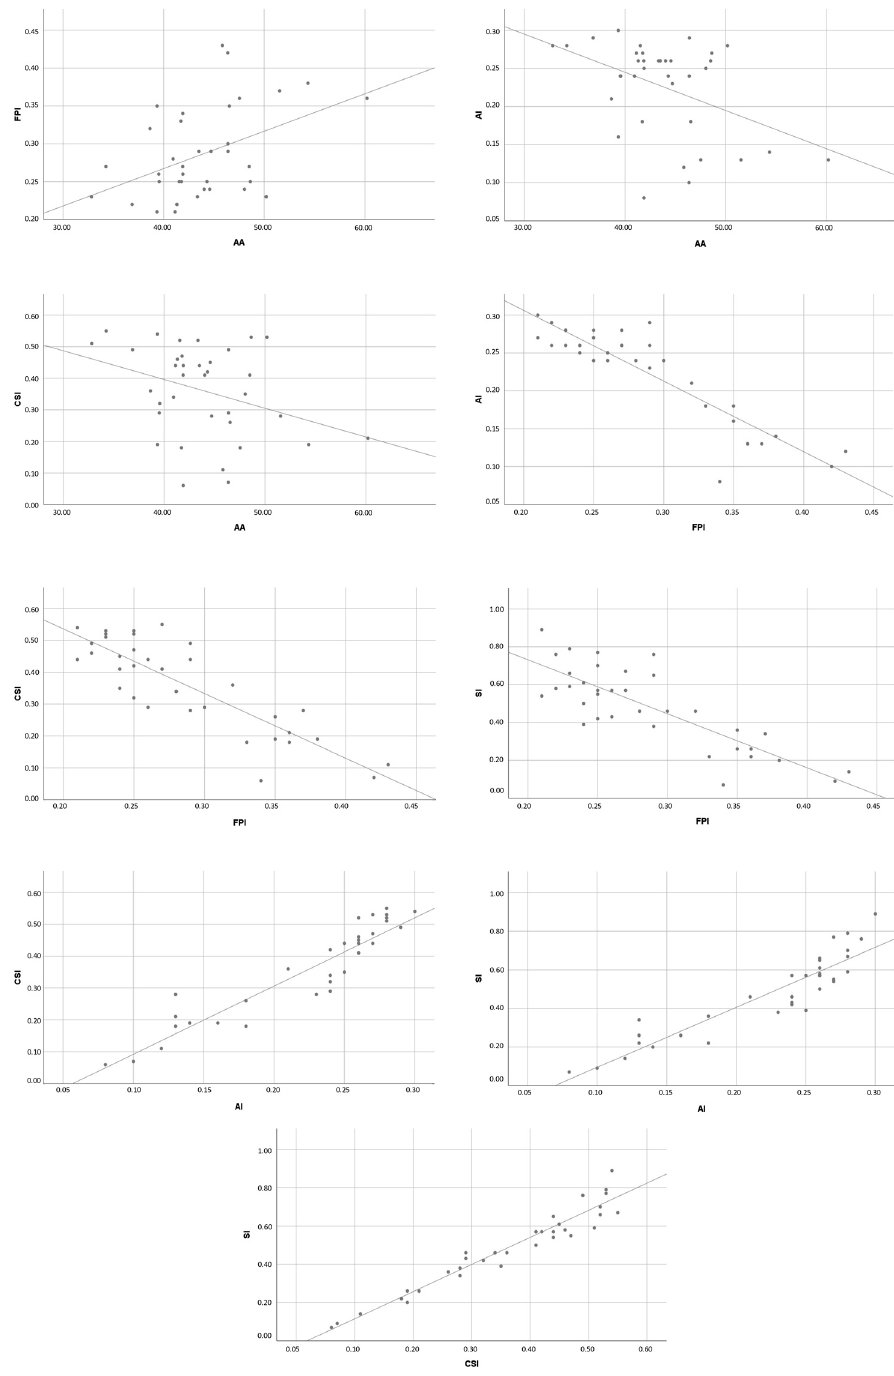
Figure 1. Significant correlations result in neutral foot subjects.